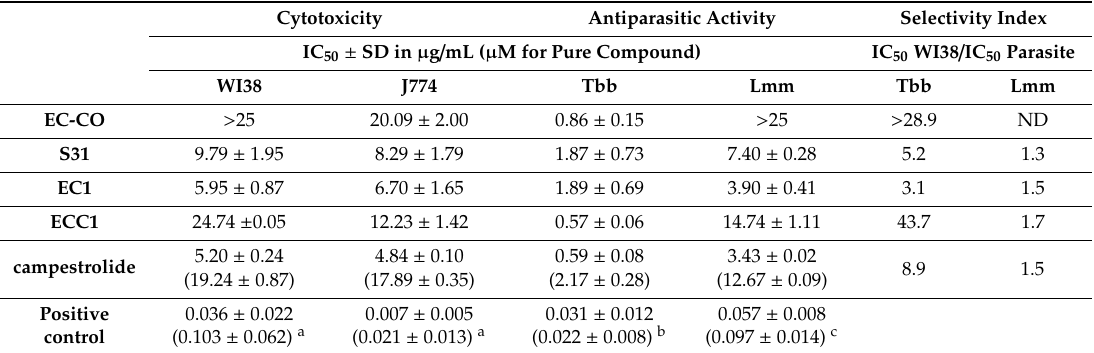
Table 5. Cytotoxicity (WI38 and J774), antitrypanosomal (Tbb), and antileishmanial (Lmm) activities expressed in the IC50 (Mean ± SD in µ g / mL and µ M for pure compounds from at least six values). Cytotoxicity Antiparasitic